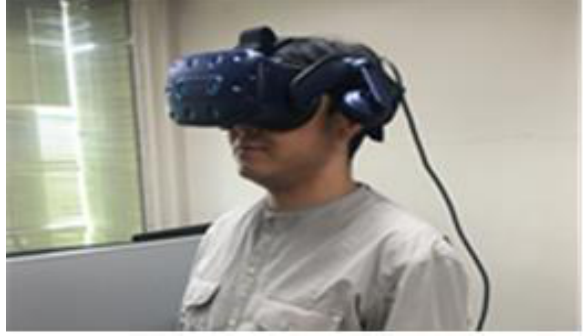
Figure 2. IVR based landscape preference experiment